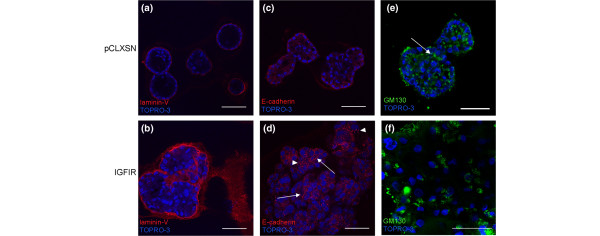
Disrupted apico-basal polarity of IGFIR structures. Equatorial confocal sections of 20-day control (pCLXSN, panels a, c, e) and IGFIR structures (panels b, d, f) labeled with antibodies to laminin V (red; panels a, b), E-cadherin (red; panels c, d) and Golgi matrix protein of 130 kDa (GM130; green; panels e, f) and the nuclear counterstain TO-PRO-3 (blue). Arrows indicate localization of E-cadherin at cell-cell junctions (panel d) and apical localization of GM130 in control structures (panel e). Arrowheads show sites of punctate E-cadherin labeling (panel d). Scale bars = 50 μm.